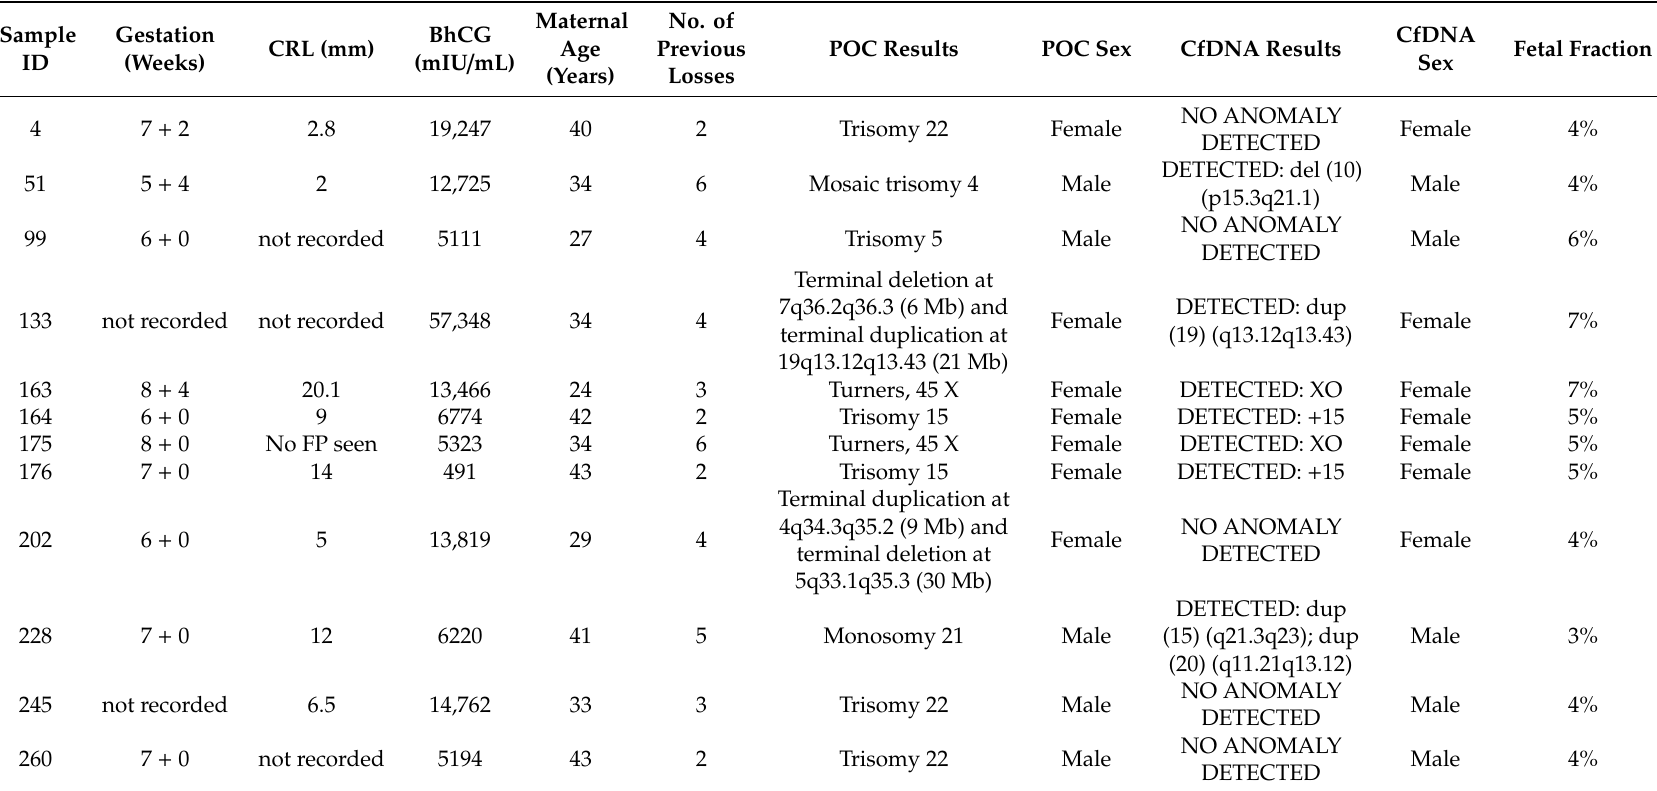
Table 2. Analysis of cfDNA using a modified Illumina VeriSeq non-invasive prenatal testing (NIPT) solution v2 workflow compared to the genetic outcomes of microarray analysis of positive POC